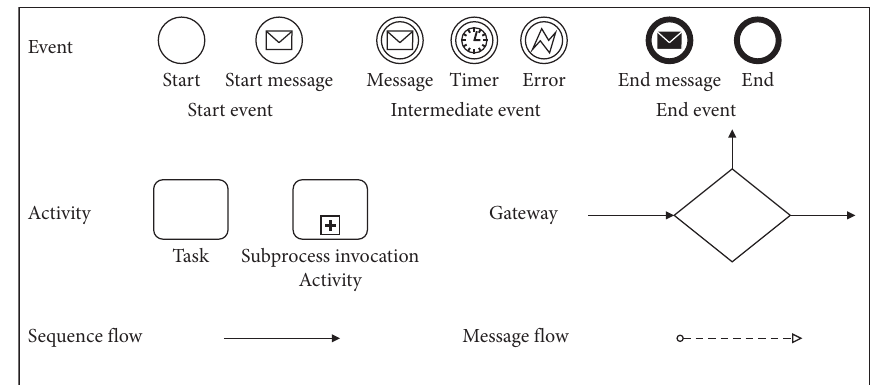
Figure 7: A core subset of BPMN